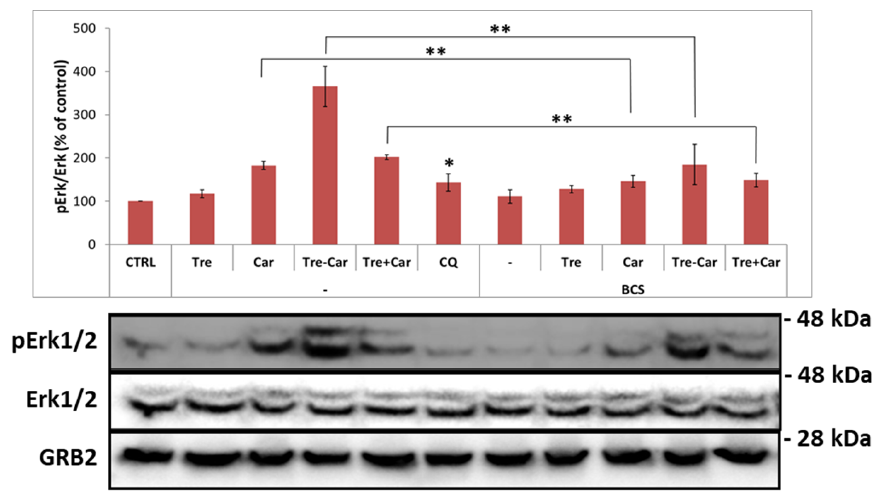
Figure 6. Erk1/2 phosphorylation results affected by Car and Tre-Car. Representative western blotting and densitometric analyses of pErk1/2 in PC12 cells treated with 5 mM of studied compounds or 10 µM CQ for 15 min in RPMI-1640 complete medium without FBS or in the presence of 50 µM BCS 24 h pre-treated RPMI-1640 complete medium. Proteins of both pErk1/2 or Erk1/2 bands were analysed/calculated separately and then expressed as the sum of the two bands. The phosphorylated level of Erk1/2 was reported as ratio over the total Erk1/2 protein (* p ≤ 0.05, ** p ≤ 0.01 versus the respective treatment). Dashes to the right of the membrane bands show positions of prestained molecular mass marker.